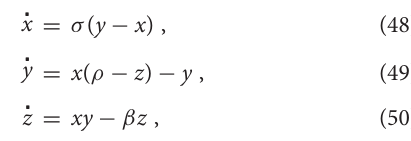
Frontiers in Applied Mathematics and Statistics |